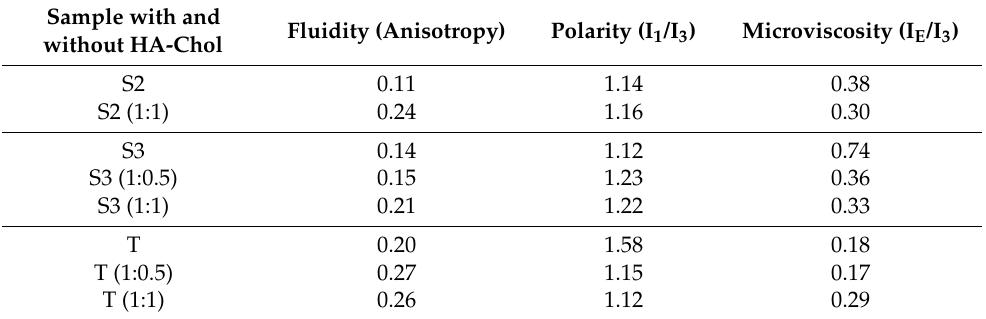
Table 3. Bilayer characterization by fluorimetric assays of uncoated and HA-Chol-coated niosomes utilizing two probes: pyrene for microviscosity and polarity assessment and DPH for fluidity evaluation.